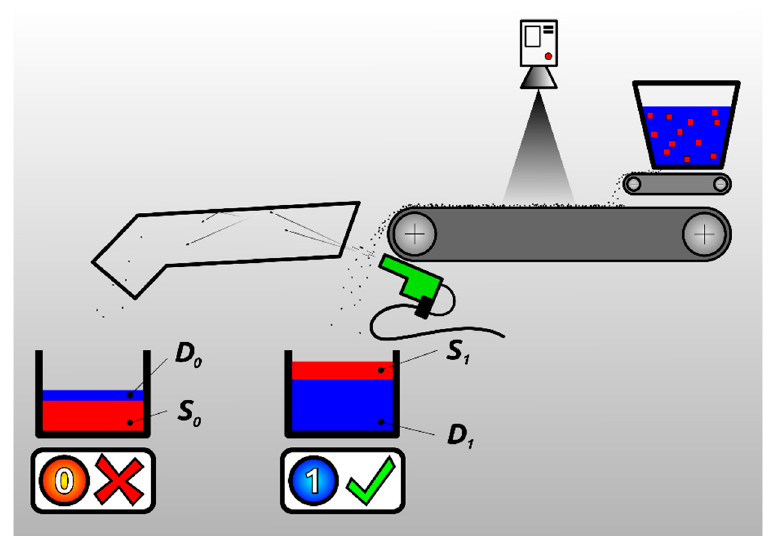
Figure 5. Schematic presentation of the system prototype. The feeder, conveyor and air nozzles are shown. Below are the boxes to catch the material. A “separate” box for non-defective material (Box 1) and an “ejected” box for defective material (Box 0).